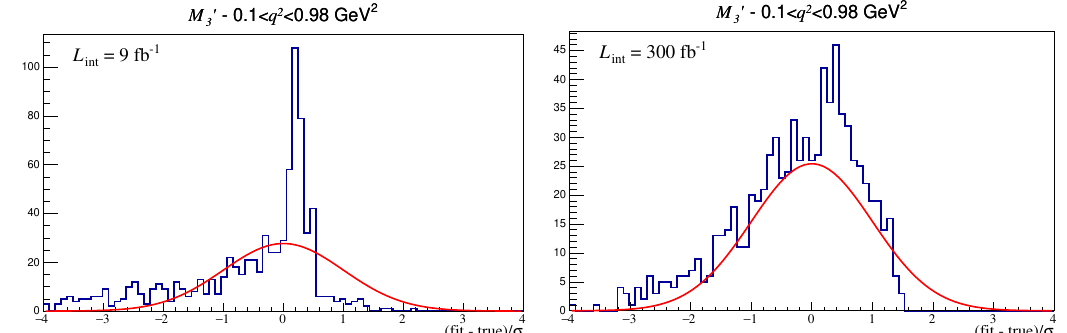
Figure 16 . The pull distributions for the optimised S-wave observable M 0 with (left) the expected LHCb Run 2 yields and (right) the yields estimated after 300 fb − 1 integrated luminosity.